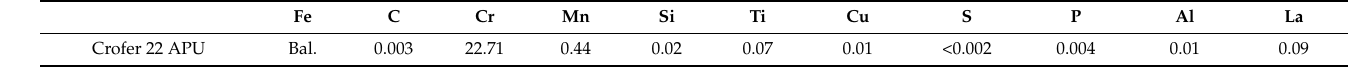
Table 3. Chemical composition of Crofer 22 APU stainless steel tested (wt%) [28].